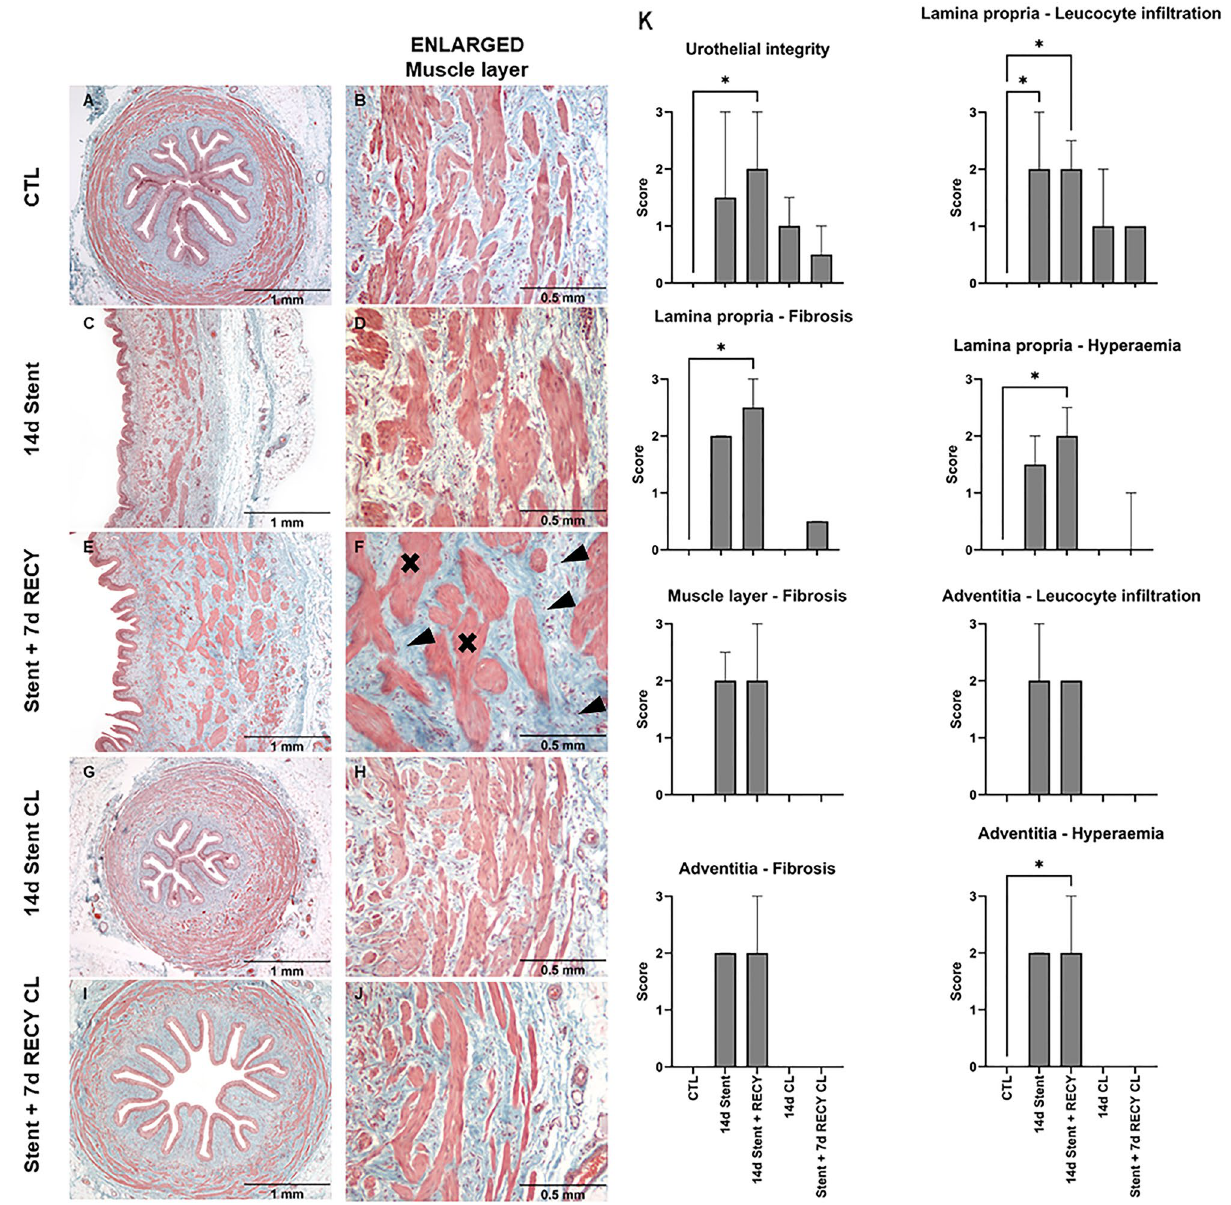
Figure 3. Qualitative evaluation of fibrotic changes in stented ureters ( A–J ). ( A,B ) Regular collagen distribution in control ureters (CTL), ( C,D ) ureters stented for 14 days (14d Stent) and ( E,F ) 14 days followed by stent removal and recovery for 7 days (Stent + 7d RECY) and ( G–J ) their unstented contralateral ureters (14d Stent CL and STENT + 7D RECYCL). High magnification images of the muscle layer showing extracellular matrix distribution between muscle bundles ( B ), gradual changes in 14d Stent ( D ) and a marked increase in extracellular matrix deposition (error head) and muscle hypertrophy (cross) in Stent + 7d RECY ( F ). Low and high magnification images of Goldners Trichrome. (K) Histopathological changes following ureteral stenting— median and SD. Scoring of urothelial integrity, leucocyte infiltration, hyperemia, fibrosis in the lamina propria and adventitia, and fibrosis in the muscular layer per condition. Three samples per condition were scored, and scoring was repeated two times. Kruskal–Wallis and Dunnett’s multiple comparison tests compare tissue alterations following UUO (p > 0.05 not